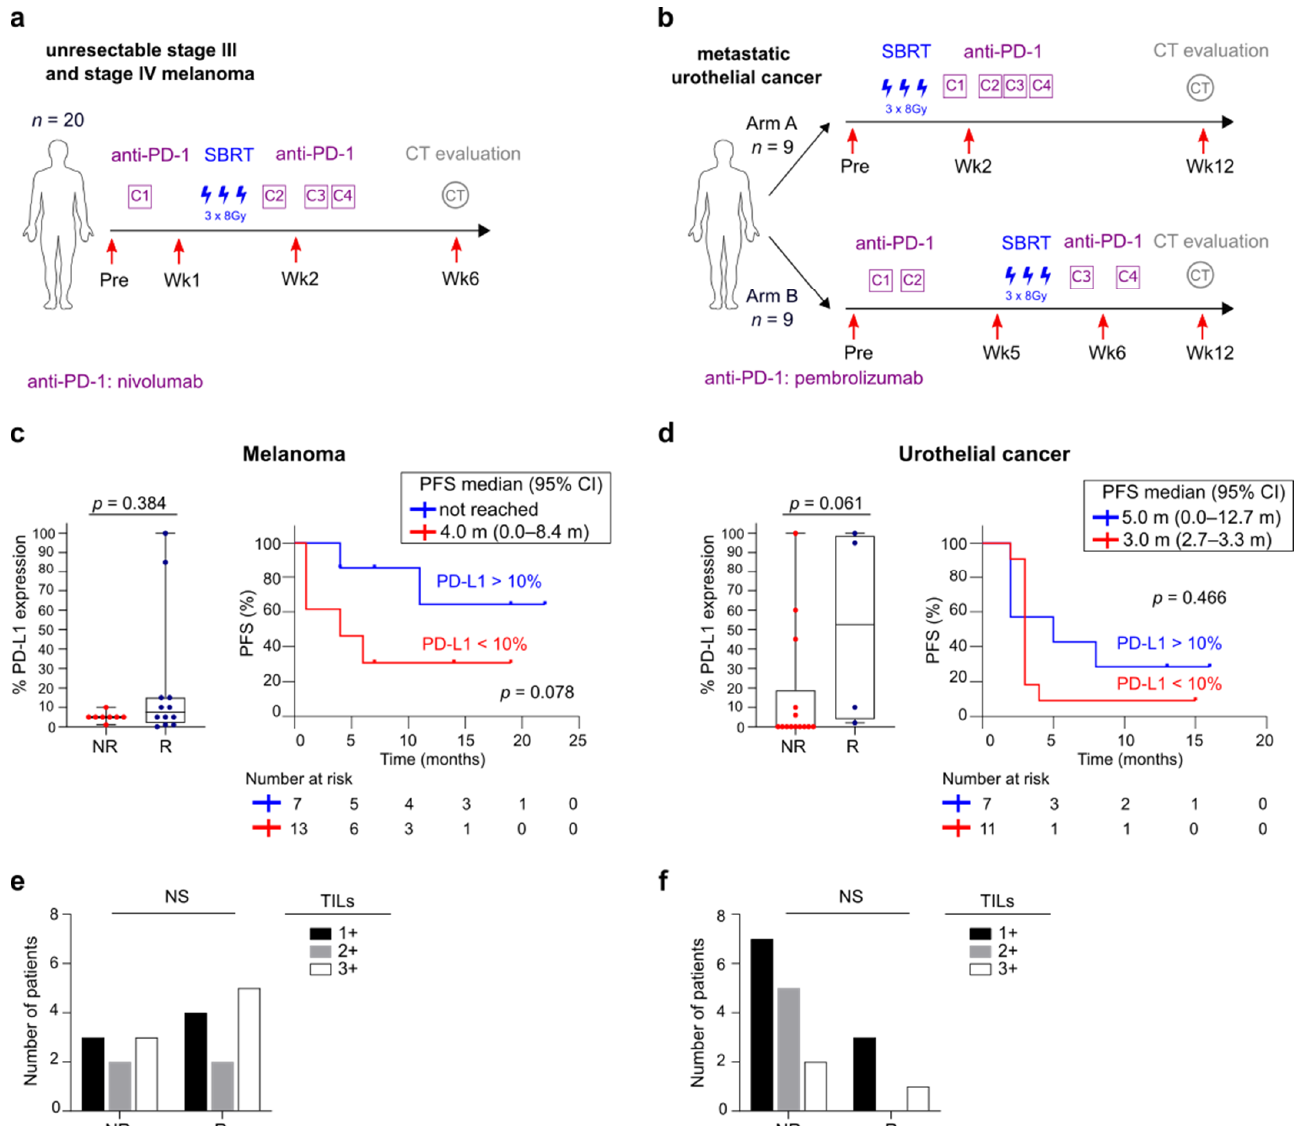
Figure 1. Overview of the clinical trial treatment strategy and PD-L1 and TIL quantification. ( a ) Schematic of design of phase 2 clinical trial in unresectable stage III and stage IV melanoma receiving a combination of anti-PD-1 and SBRT. ( b ) Schematic of design of randomized phase 1 trial combining anti-PD-1 with either sequential (Arm A) or concomitant SBRT (Arm B) in metastatic UC. Red arrows indicate time of blood collection. ( c ) Boxplots with tumoral PD-L1 expression in non-responders and responders (left) and Kaplan-Meier estimate of PFS stratified according to tumoral PD-L1 expression (right) in melanoma and ( d ) in UC. Whiskers of boxplots extend to the minimum and maximum data point, with the horizontal line indicating the median. p value calculated using two-sided Mann-Whitney U test (left) and log-rank test (right). ( e ) TIL quantification in non-responders and responders in melanoma and ( f ) in UC. TILs were evaluated semi quantitatively: 1+, sporadic TILs; 2+, moderate number of TILs; 3+, abundant occurrence of TILs. p value calculated using Fisher’s exact test. Pre, pre-treatment; Wk, week; Gy, gray; SBRT, stereotactic body radiotherapy; CT, computed tomogra- phy; NR, non-responder; R, responder; PFS, progression free survival; NS, not significant; TIL, tumor infiltrating lympho- cytes.